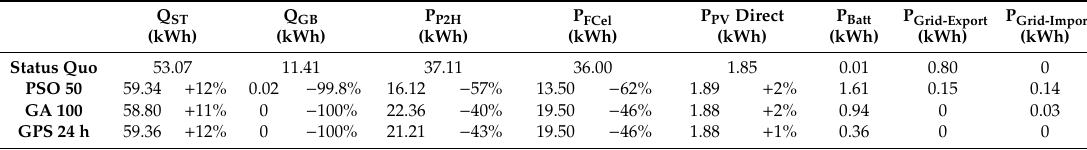
Figure 14. Manipulated variables of the optimized fitness of each algorithm plotted with the initial iteration and the status quo on the spring day. Table 4. Key energy values from the best point of each optimized control on the spring